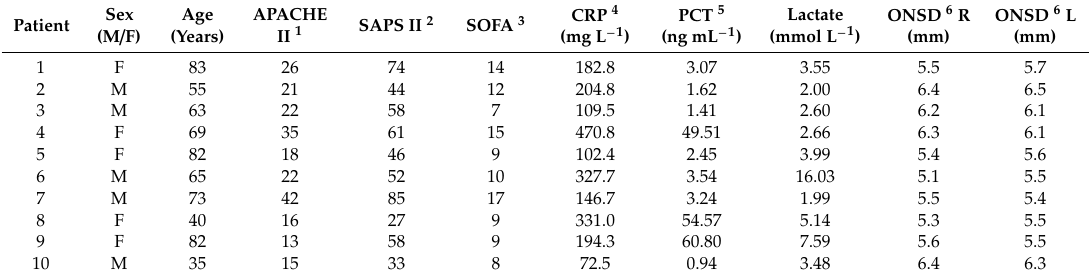
Table 1. Demographic, clinical and laboratory parameters of patients on the first day of observation.